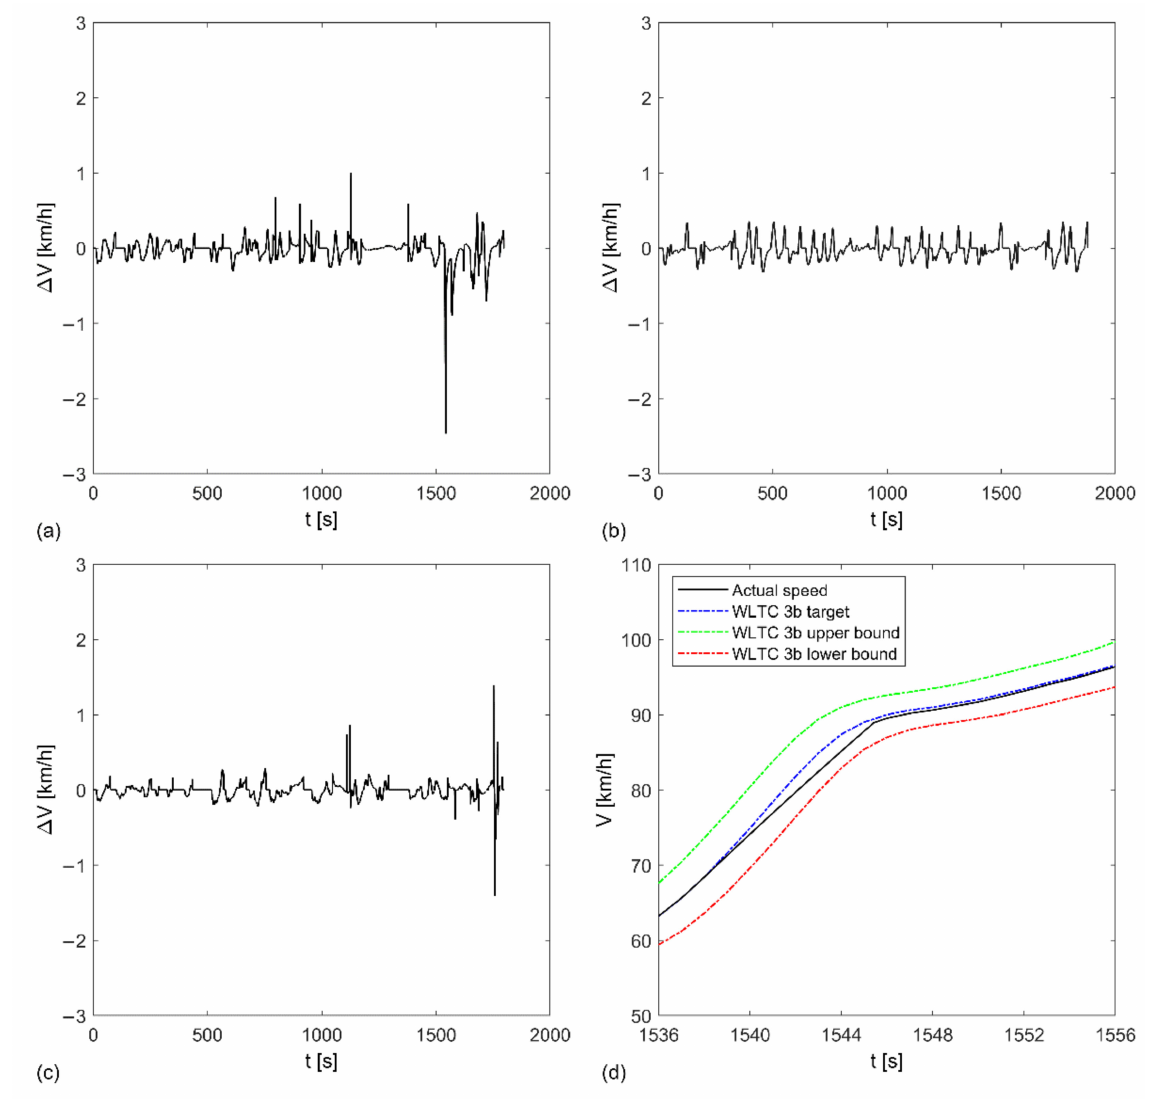
Figure 7. Plots of the speed difference between simulated vehicle speed and ideal cycle speed versus time given by ( a ) WLTC 3b, ( b ) FTP-75, and ( c ) CLTC-P. Plot ( d ) shows the biggest speed difference occurring in WLTC, but still staying within allowed bounds.